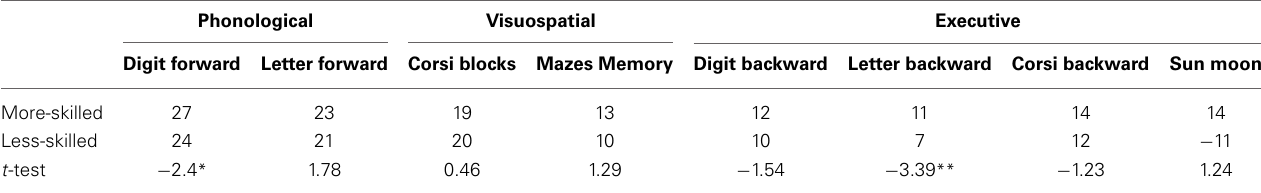
Table 2 | Scores on the working-memory tasks for more- and less-skilled transcoders.